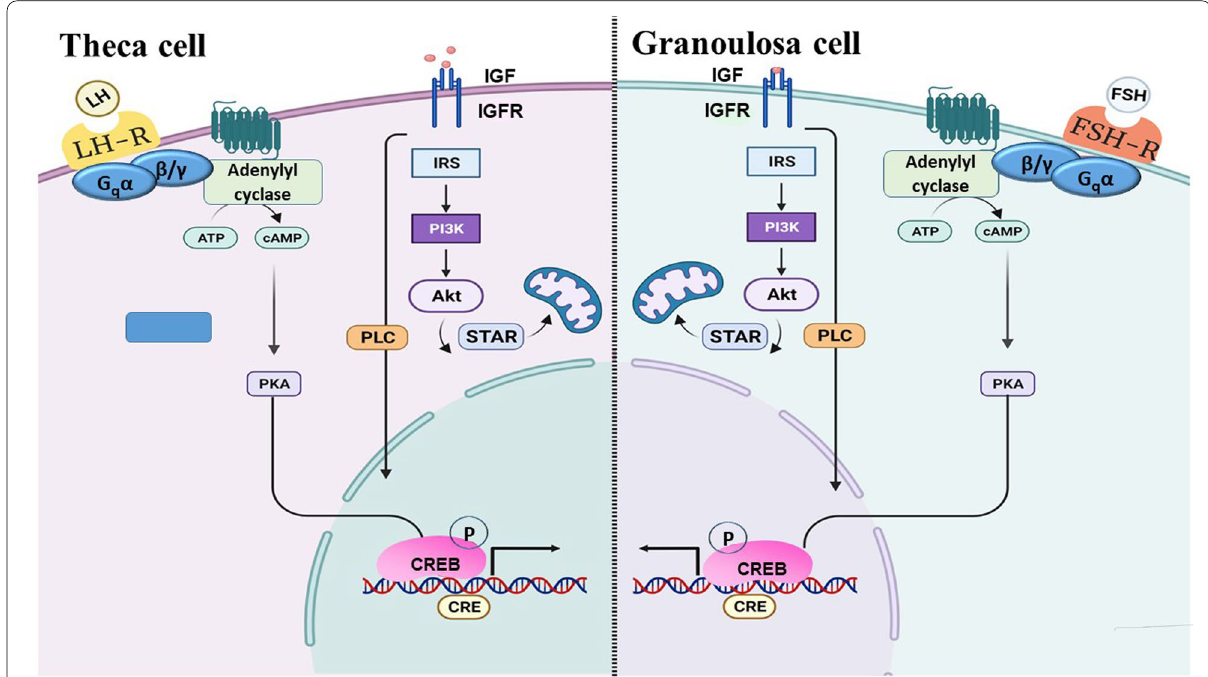
Fig. 2 IGF signaling in theca and granulosa cells. Created with BioRe nder.